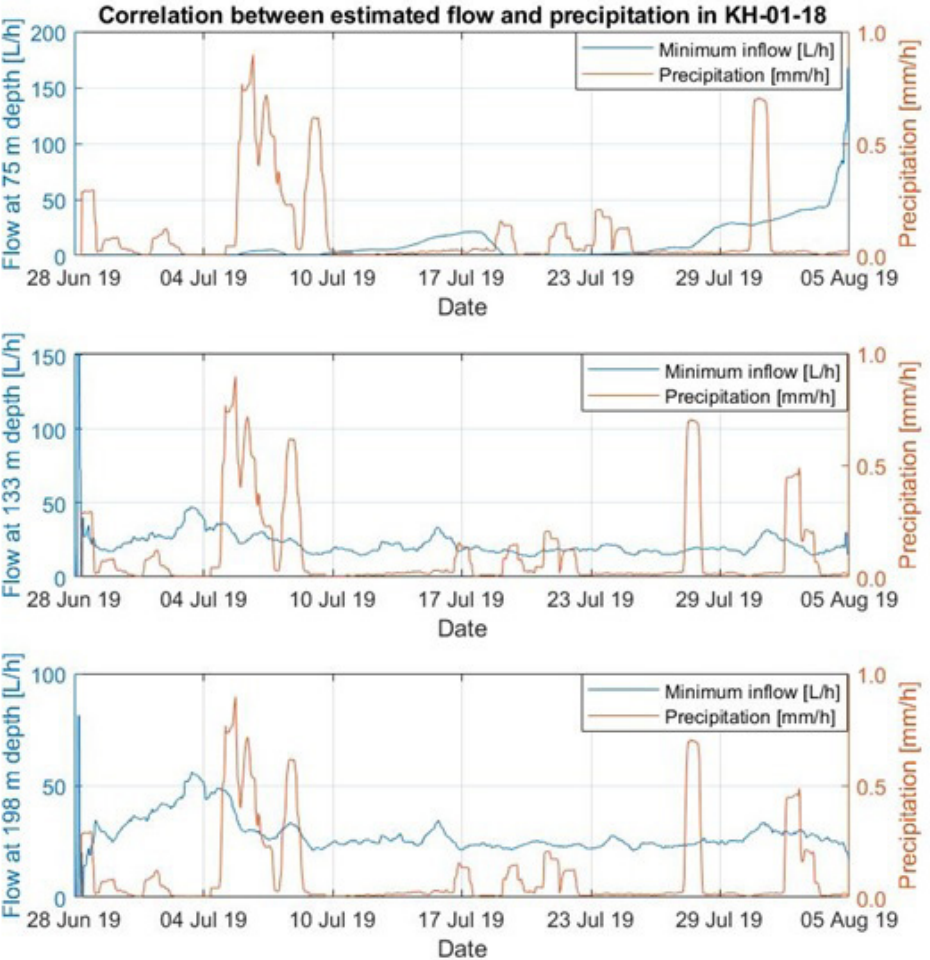
Figure 8. Estimated groundwater flow in KH-01-18 (moving daily averages) and their correlation with precipitation (moving daily averages): No clear trend was found; the highest correlation factor was 0.11.